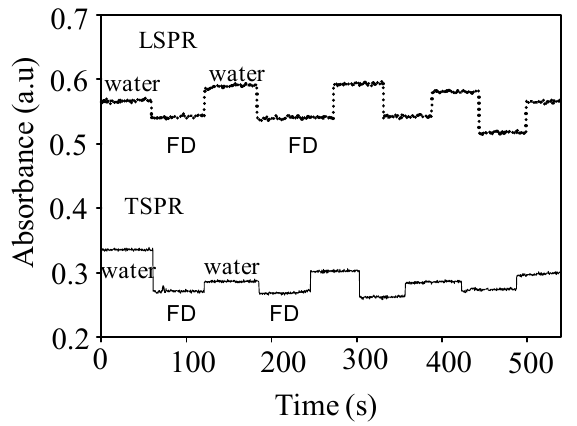
Figure 8. Plasmonic responses of GNR upon the presence and absence of FD (10%) measured at the TSPR and LSPR peaks’